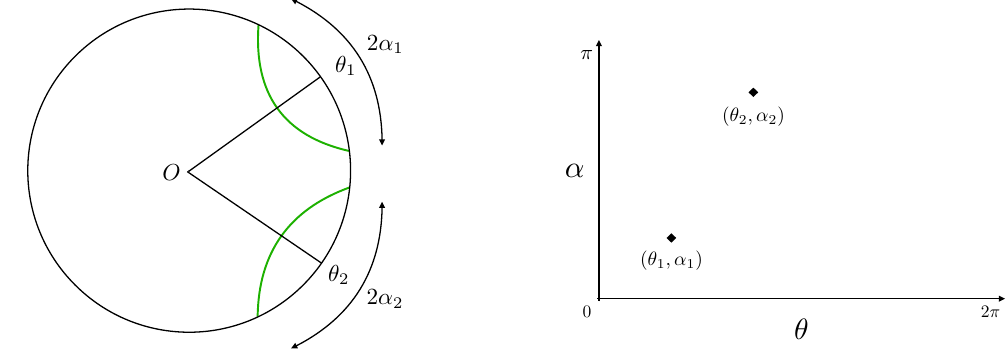
Figure 1 . Left diagram: a time slice of pure AdS 3 containing two boundary anchored geodesics (in green) parametrized by ( θ 1 , α 1 ) and ( θ 2 , α 2 ) . Right diagram: the associated two points in kinematic space with coordinate system ( θ, α ) , where θ denotes the midpoint of the boundary subregion in angular coordinates and α is the angular radius. The orientation of each geodesic is reversed by the transformation ( θ, α ) → ( π + θ, π − α ) , which exchanges the boundary subregion with its